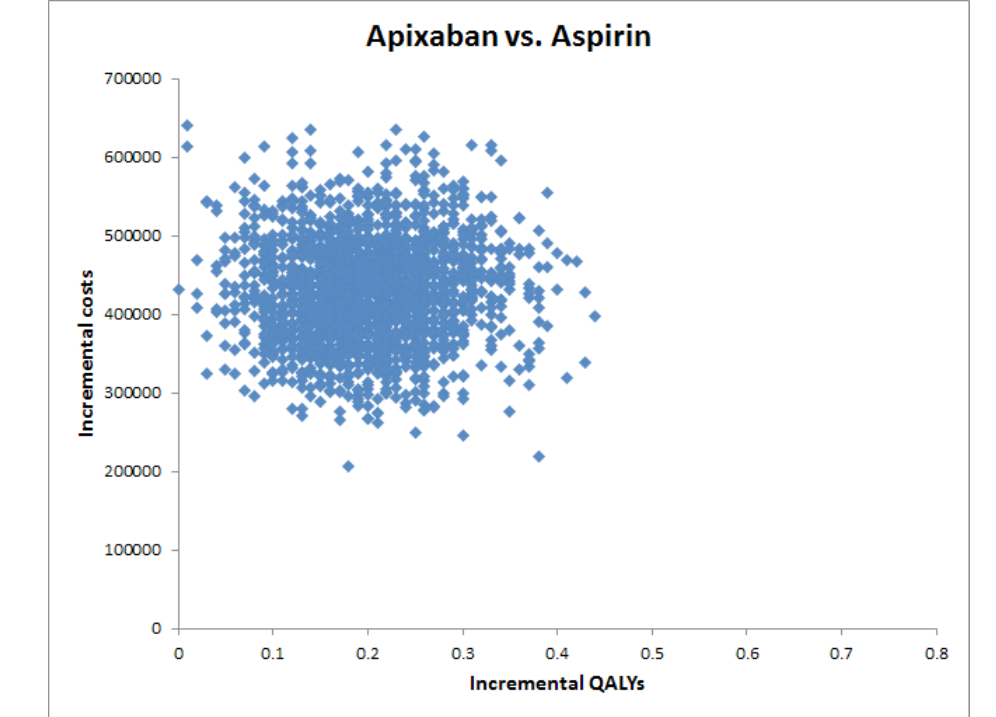
Figure 3. Results of Probabilistic Sensitivity Analyses for the VKA-unsuitable Population a) Cost-effectiveness plane for apixaban versus aspirin (incremental costs and